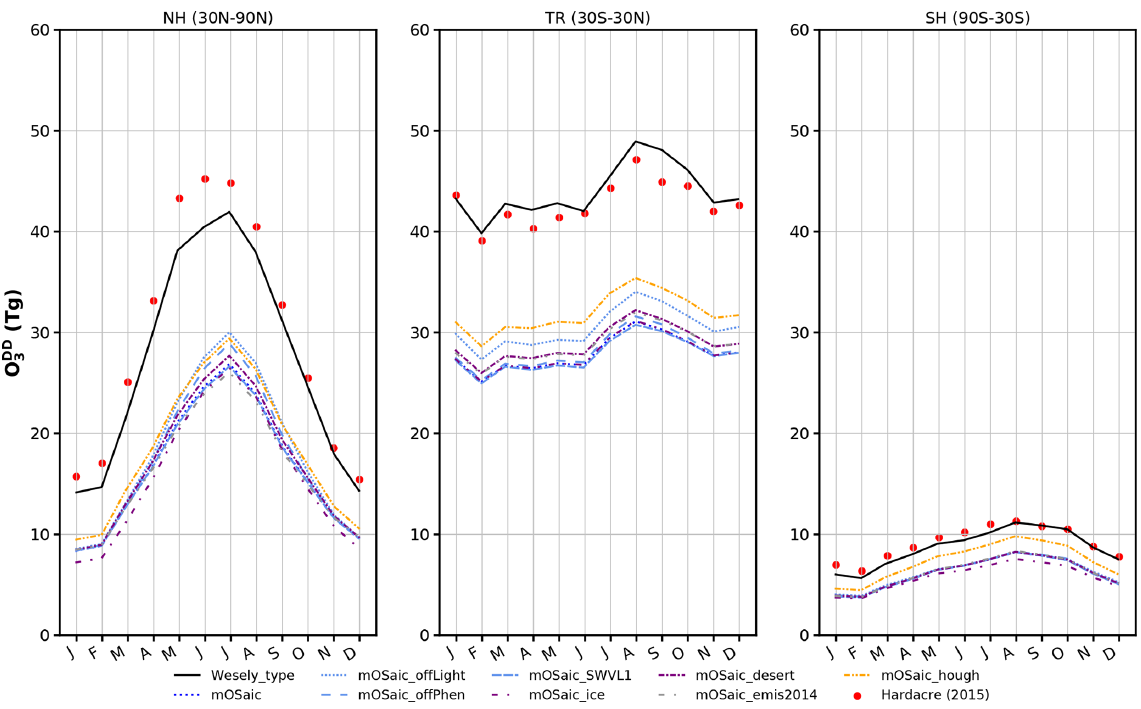
Figure 6. Seasonal cycle of total annual amount of ozone removed from the atmosphere through dry deposition separated into the NH, tropics (TR), and SH. The multi-model mean from the evaluation of HTAP models by Hardacre et al. (2015) is shown as a